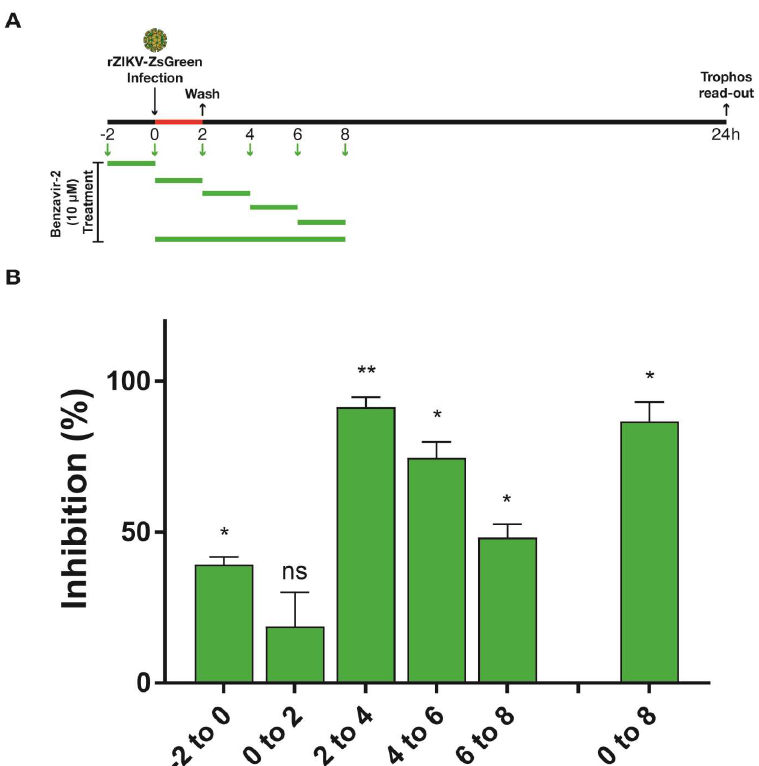
Figure 5. Time-of-addition assay of benzavir-2 using rZIKV-ZsGreen. 10 4 Vero B4 cells per well were seeded in a 96-well black plate with transparent bottoms the day prior to the experiment. ( A ) Illustration displaying the experimental set-up. Briefly, to perform the assay with the pre-treatment condition ( − 2–0 h), the media from each well was replaced with 10 µ M benzavir-2 in DMEM, containing 1% fetal bovine serum (FBS) for 2 h at 37 ◦ C. Thereafter, cells were infected with 0.2 MOI of rZIKV-ZsGreen for 2 h at 37 ◦ C, followed by the addition of fresh DMEM. In the 0–2 h wells, 10 µ M benzavir-2 was added together with the virus for 2 h and was replaced with fresh DMEM. For the 2 h benzavir-2 treatment intervals, the virus was removed from all the wells 2 h post-infection (hpi) and was replaced with 10 µ M benzavir-2 in DMEM every second hour (2–4 h, 4–6 h, or 6–8 h). To treat benzavir-2 for 8 h (0–8 h), the cells were treated with 10 µ M benzavir-2 together with the virus for 2 h and the medium was replaced with 10 µ M benzavir-2 in DMEM for an extra 6 h. ( B ) After 24 h of infection, the Trophos plate runner HD identified all individual ZsGreen-expressing cells and quantified the fluorescence intensity in each well. Mean values and standard deviations from three independent experiments are shown. The statistical significance was determined by one-way ANOVA, followed by Dunnett’s multiple-comparisons test. * p < 0.05, ** p < 0.01; not significant